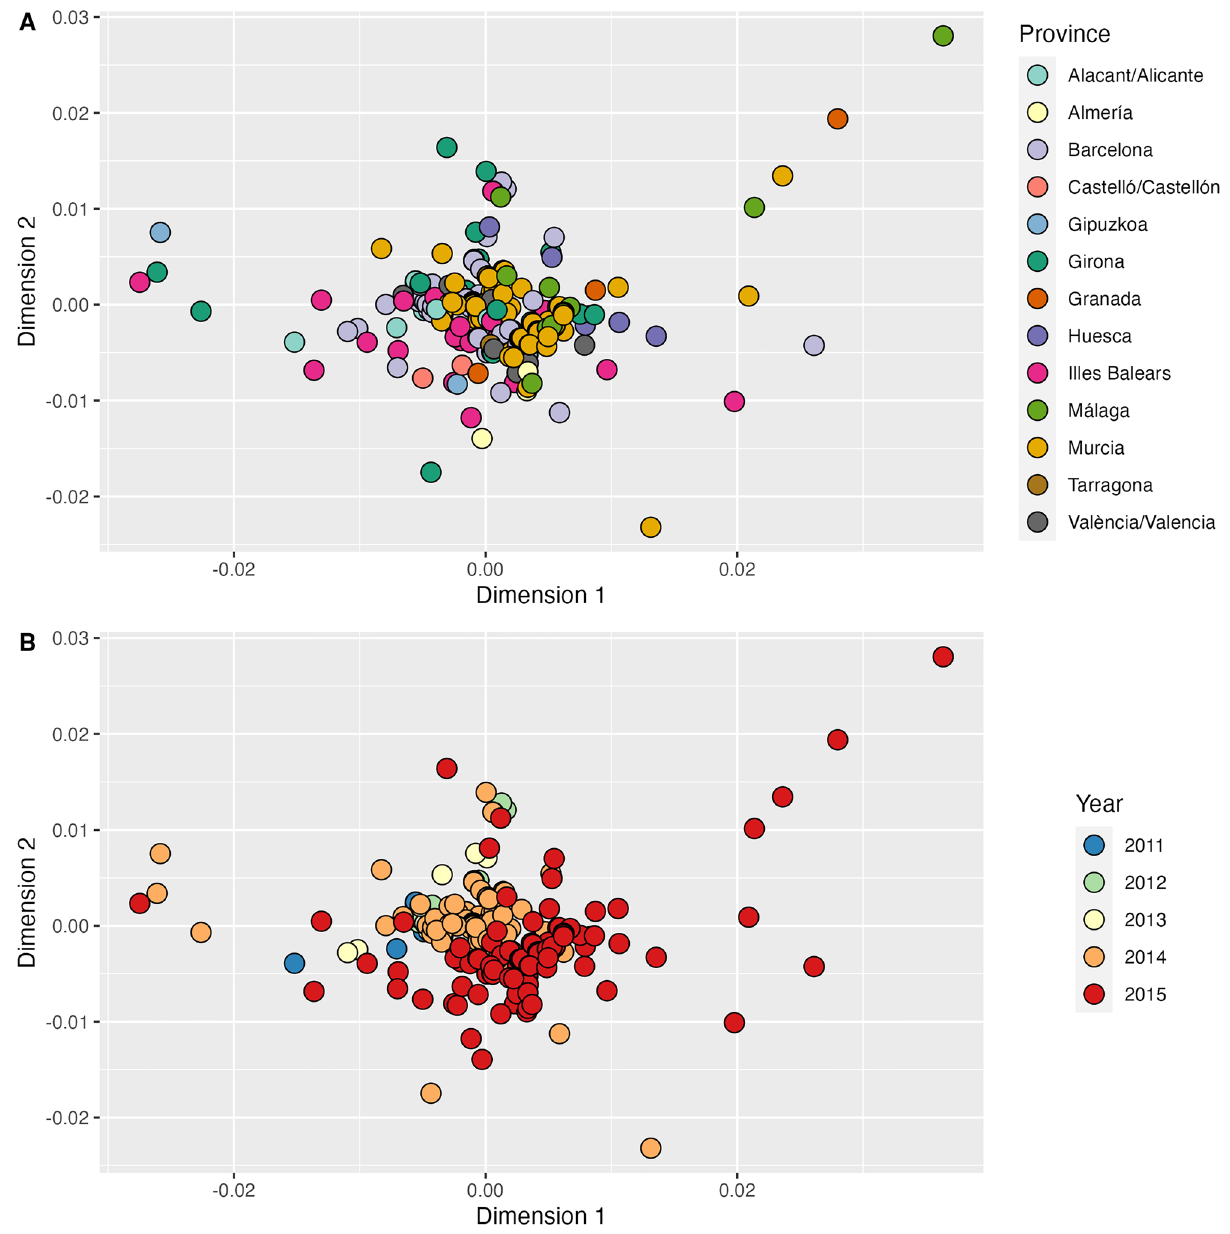
Figure 4. Multidimensional scaling plots of ITS2 genetic distances among Ae. albopictus samples, coloured by province ( A ) and year ( B ) of sample collection. Plots show the 2-dimensional solution using classical scaling. Goodness of fit =